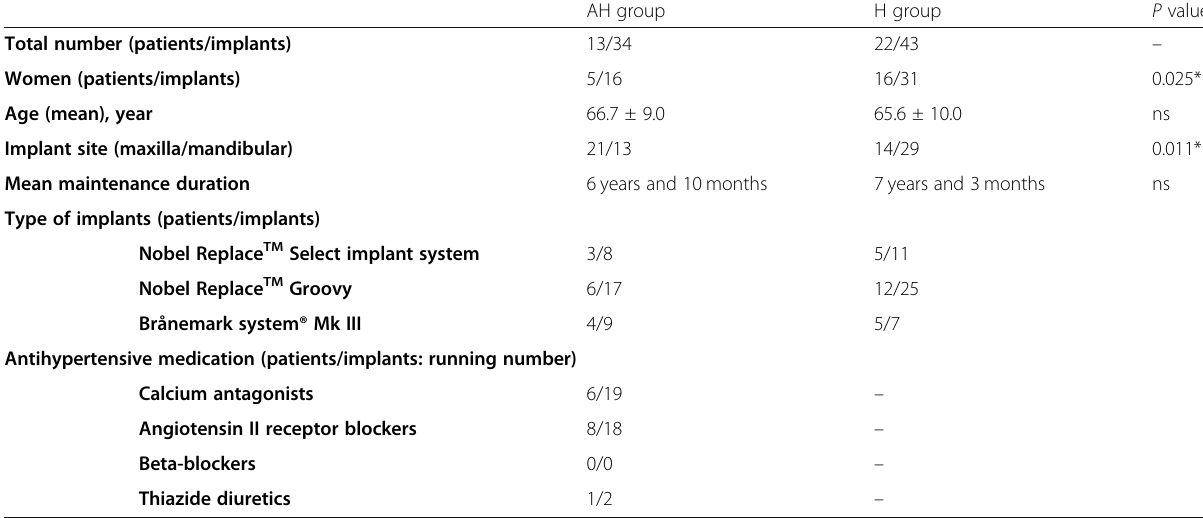
Table 1 Characteristics of the patients in the AH and H